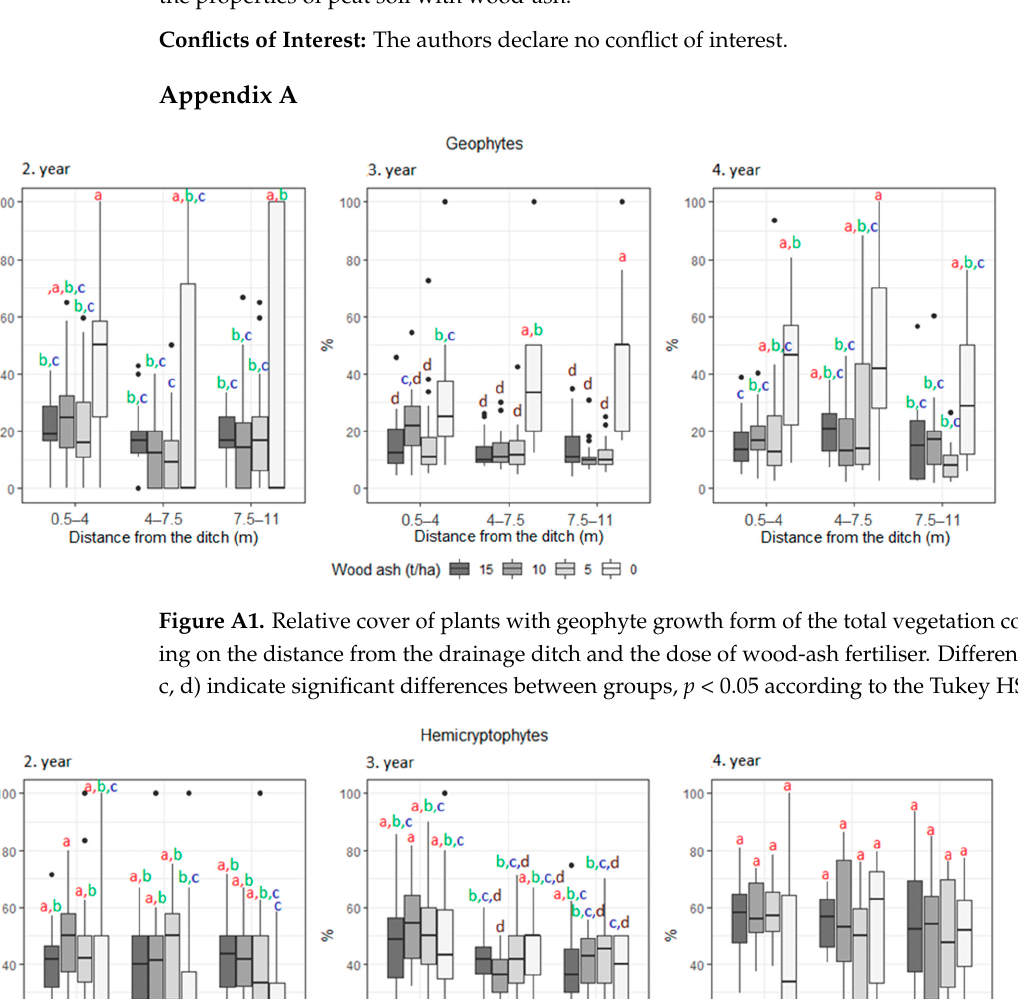
Figure A3. Relative cover of plants with therophyte growth form from the total vegetation cover, depending on the distance from the drainage ditch and the dose of wood-ash fertiliser. Different letters (a, b, c) indicate significant differences between groups, p < 0.05 according to the Tukey HSD test.